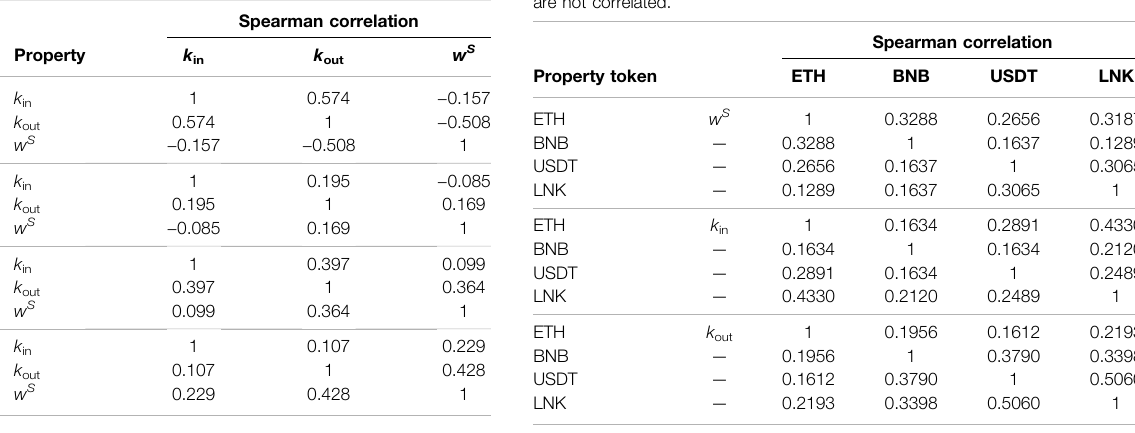
TABLE 4 | Spearman correlation between k in (in-degree), k out (out-degree), w S (wealth) for each cryptoasset. All p -values are lower that 10 – 10 , implying that we can reject the null hypothesis that the variables are not correlated.